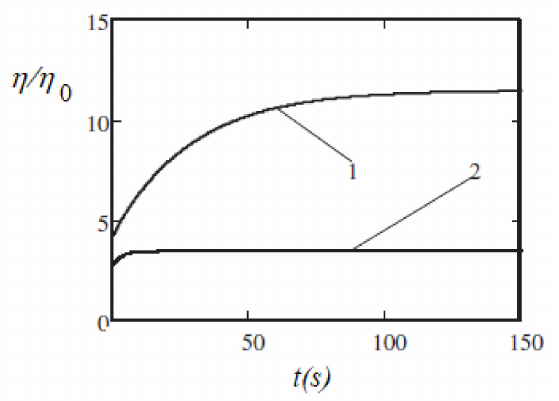
Figure 9. The time dependence [92] of the e ff ective viscosity η after a stepwise decrease of the shear . γ rate from 16 s − 1 to 1.6 s − 1 at t = 0. Curve 1—the dimensionless magnetic field κ = 3 Curve 2— κ = 1. Parameters of the system: the hydrodynamic diameter (with the surface layers) of the particles was 16 nm, the volume concentration of the particles was ϕ = 0.015, the dipolar coupling was λ = 2.75, the viscosity of the carrier liquid η 0 = 0.13 Pa · s. Published with the permission of the American Physical Society (license RNP / 20 / AUG /